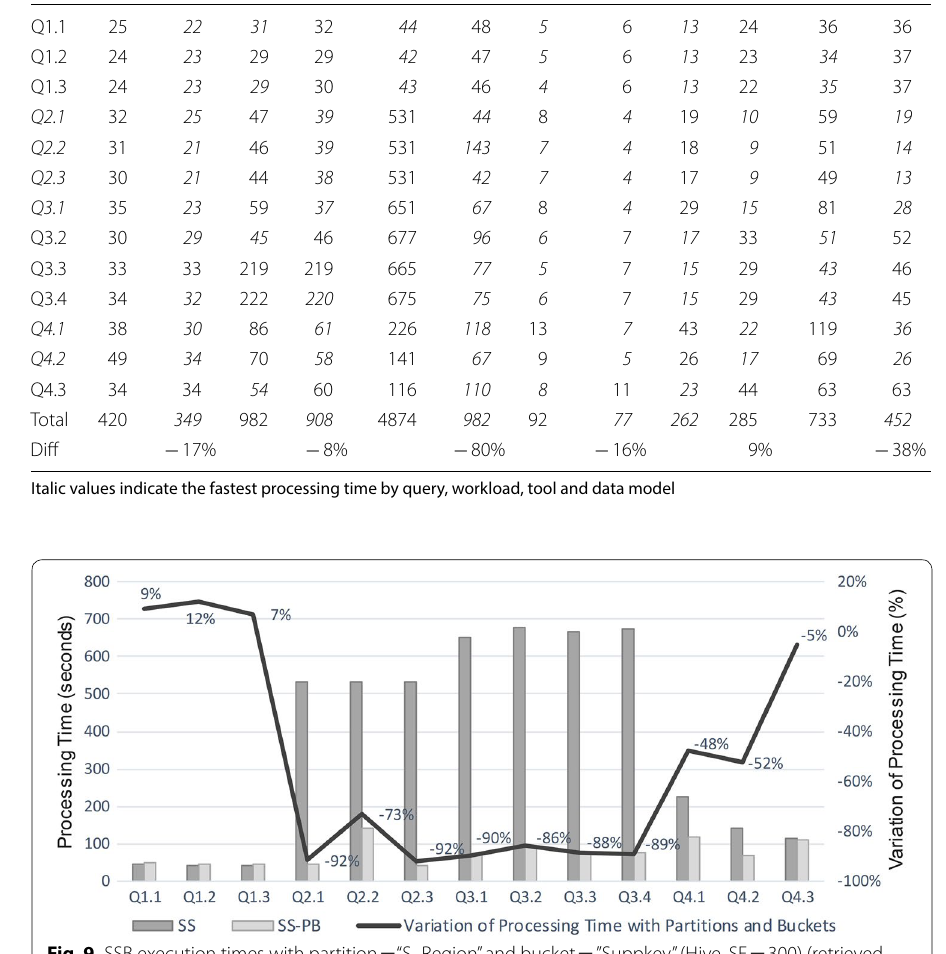
“S_Region” and bucket =